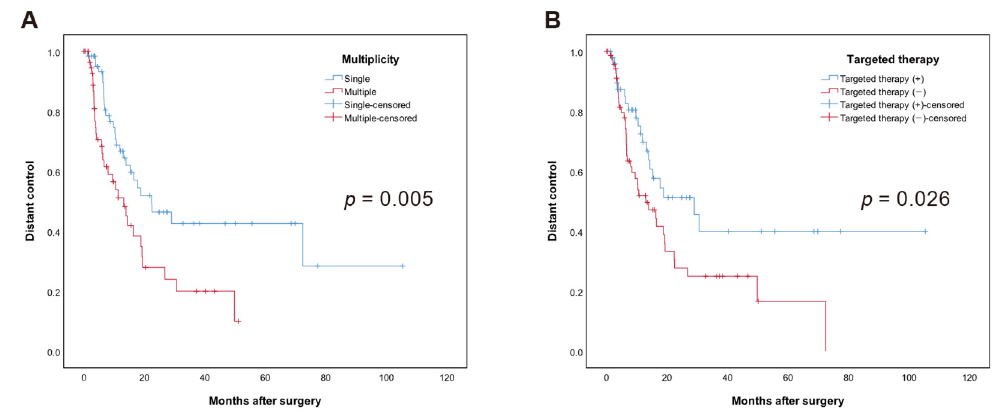
Figure 3. Kaplan–Meier curves of distant control (DC) in months among 124 patients. ( A ) Median distant-free survival time was 22.4 vs. 13.2 for single vs. multiple brain metastases, respectively ( p = 0.005), ( B ) Median distant-free survival time was 29.0 vs. 13.0 with use of targeted therapy vs. no use of targeted therapy ( p = 0.026).